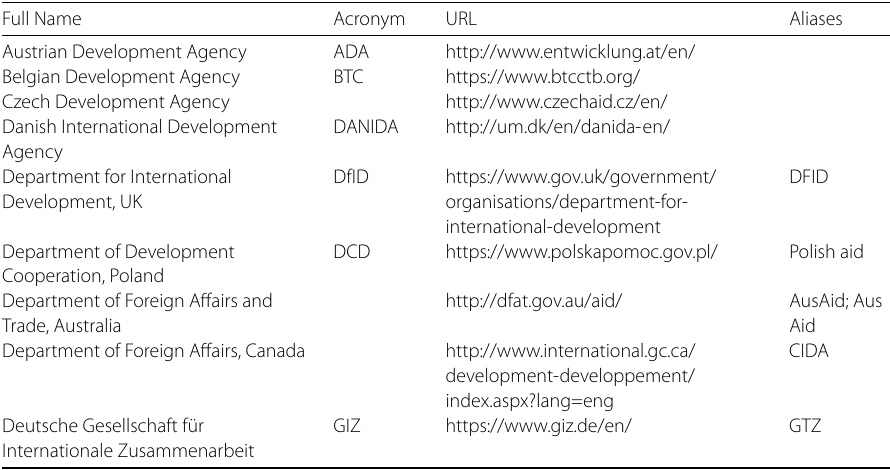
Table A2 The list of organizations on which this study focuses Full